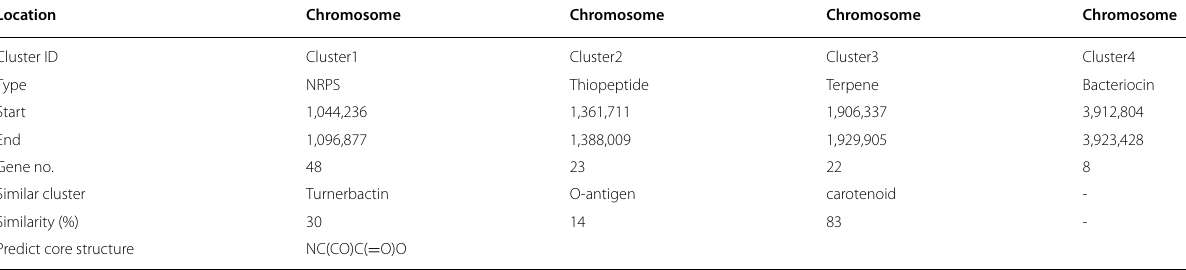
Table 4 Putative gene clusters for secondary metabolites identified by